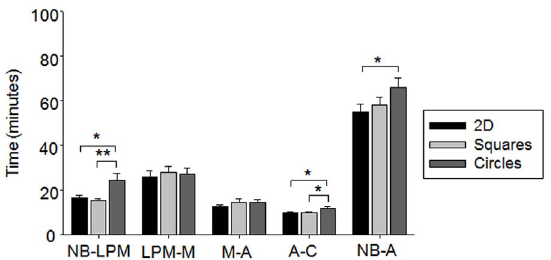
Figure 3. The effect of cell shape on the cells’ progression through mitosis. HeLa cells (RFP-tubulin/GFP-H2B) were synchronized and cultured on 2D homogenously coated substrates (black bars) or within square (light grey bars) or circular (dark grey bars) microwells and assessed for the time required to progress through each stage in mitosis. Cells cultured in circular microwells took longer to progress through mitosis and specifically to reach late prometaphase, than cells cultured in square microwells or on 2D substrates. All values represent time in minutes 6 SEM. Key: * p , 0.05, ** p , 0.01; NB = nuclear envelope breakdown, LPM = late prometaphase, M= metaphase, A= anaphase, C= cytokinesis.